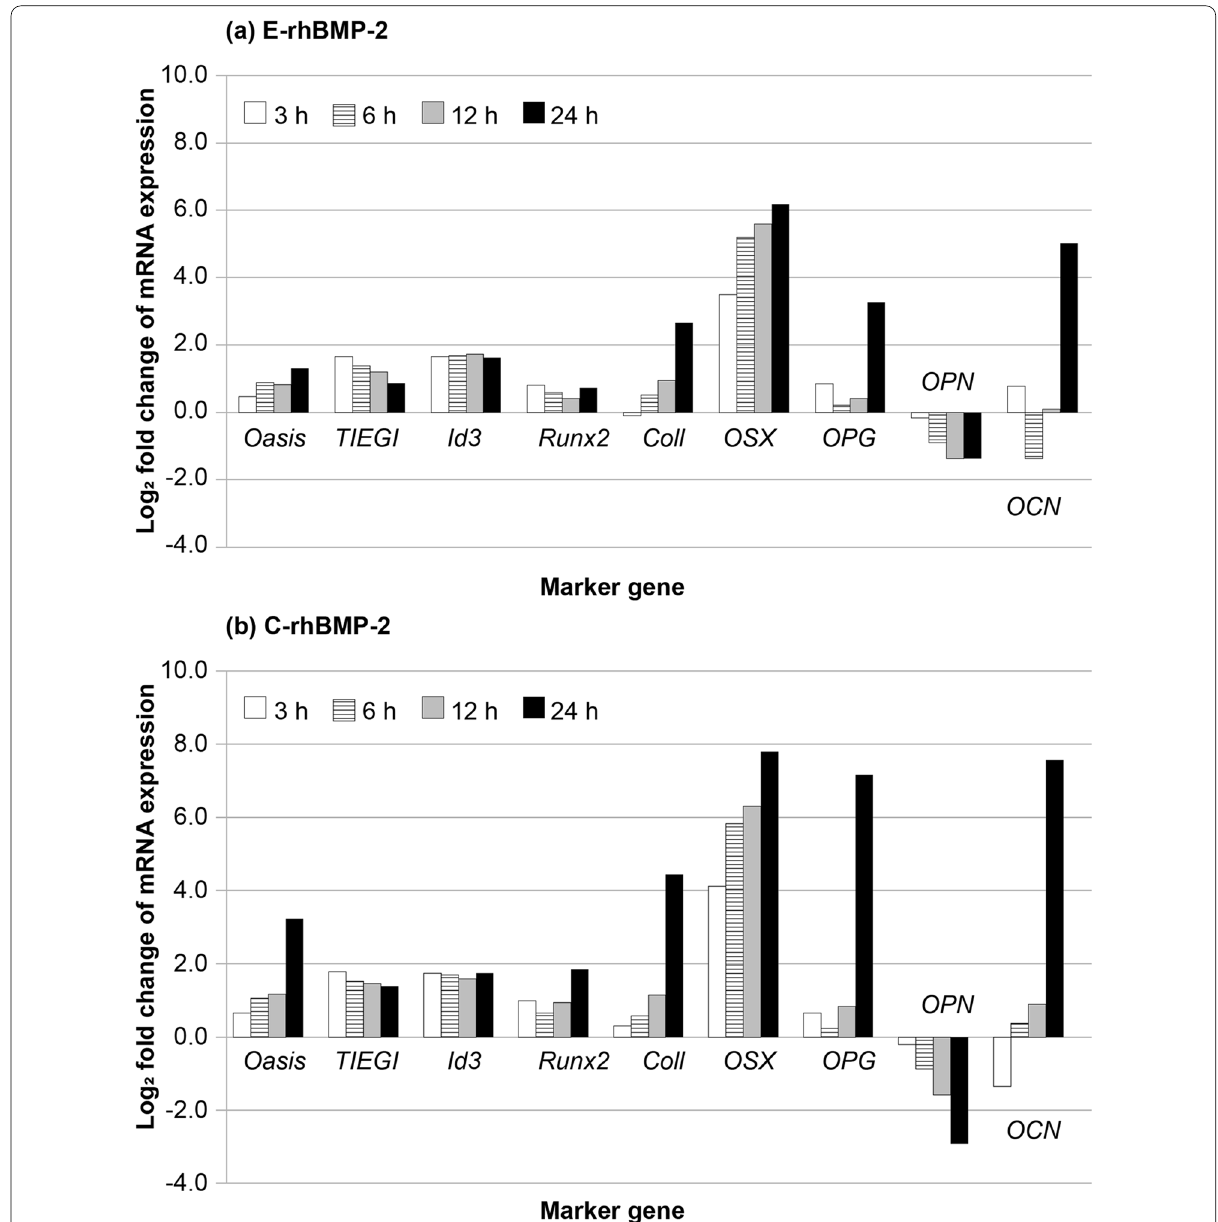
Fig. 4 Time‑series expression profile of osteogenic marker genes after rhBMP‑2 treatment. a E‑rhBMP‑2, b